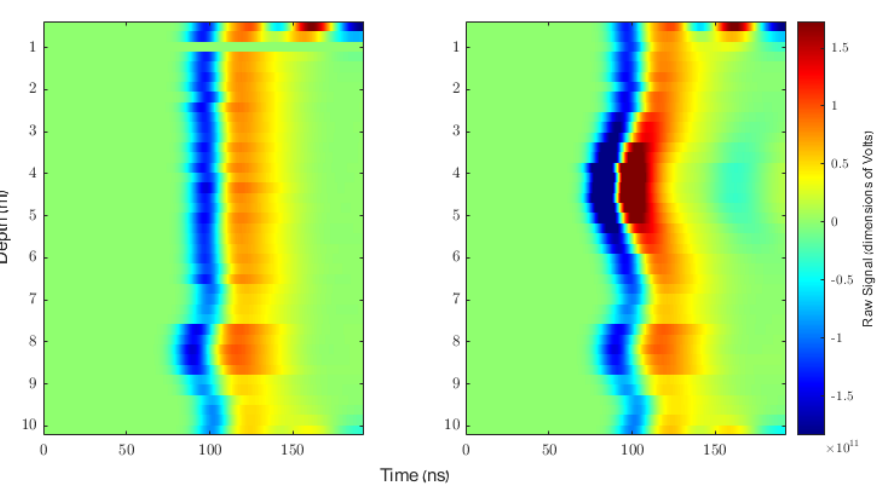
Figure 10. A representative pair of profiles taken over the simulated stratified soils described in Appendix B. The two profiles were taken over soil which was simulated identically other than the cavity which exists at around four meters below the surface in the profile on the right. The profiles showcased in this figure were used to draw the pair of likelihood-ratio curves shown in the top right-hand corner of Figure 11. The strange behaviour of the signal at the shallowest and deepest depths appears to be the result of numerical artifacts and should have been ignored by our method due to its CFAR-style nature. The signals were cropped to show only the most relevant portions.